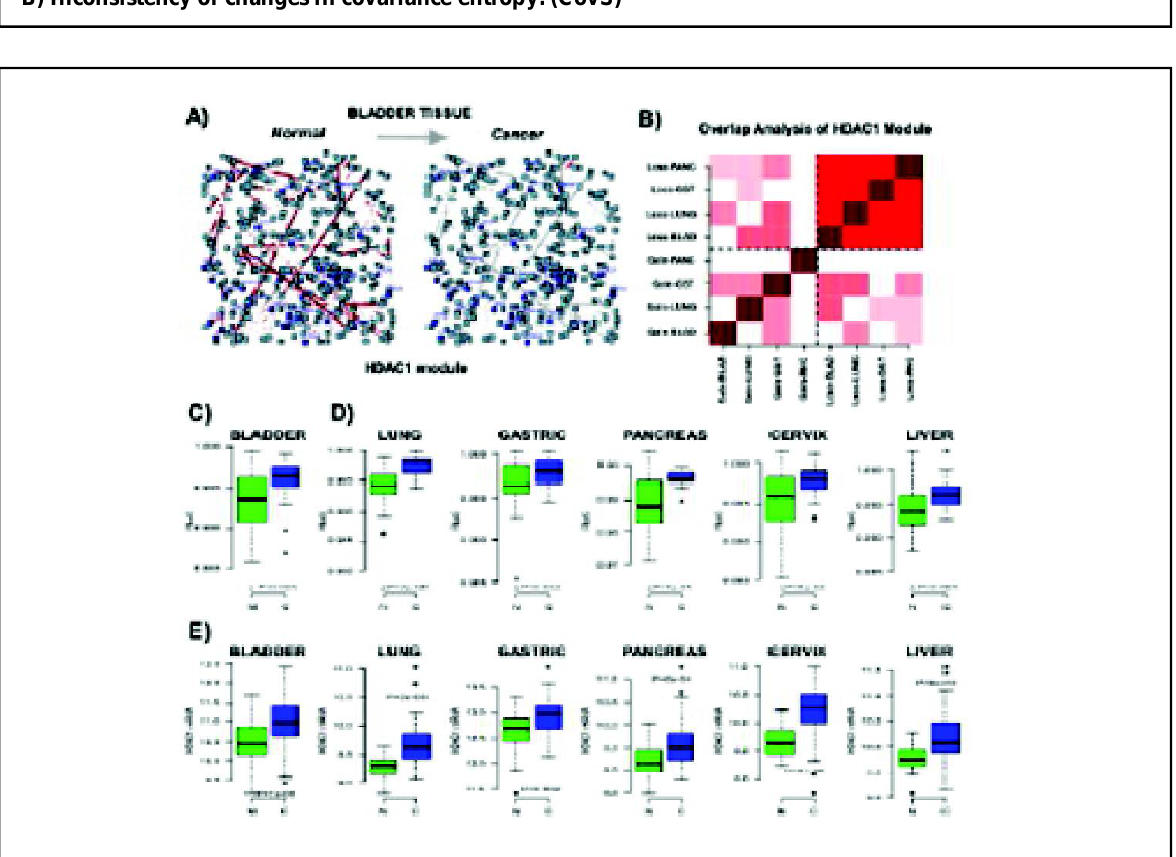
Figure 4: Identification of an HDAC1 module associated with increased dynamical entropy and loss of function in